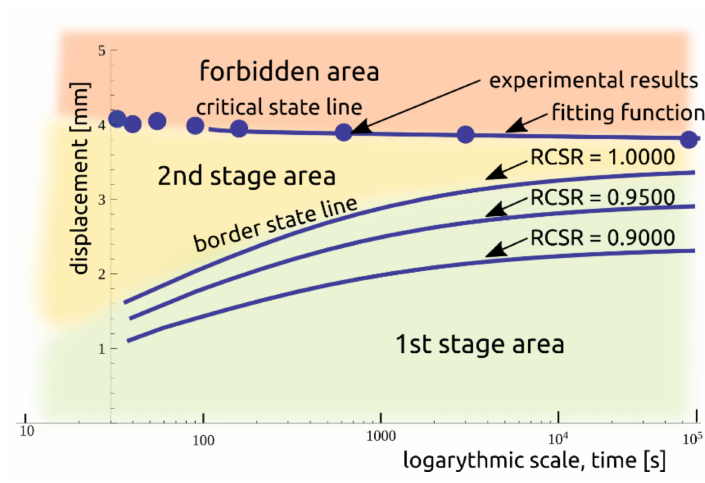
Figure 10. The contour map of creep phenomenon